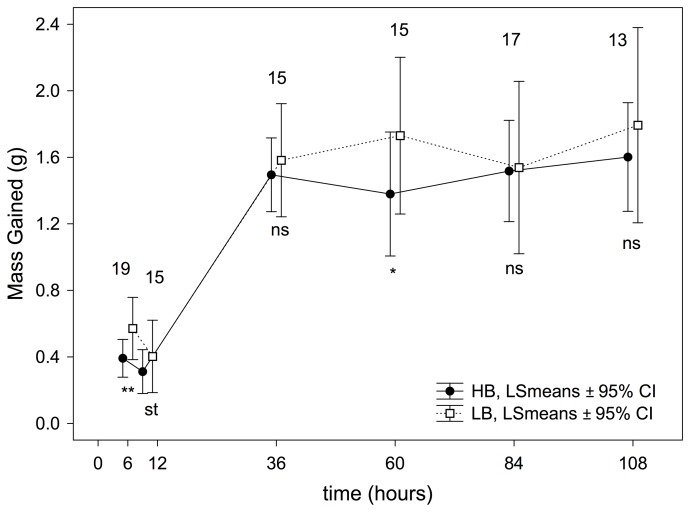
Effect of the experimental treatment on mass gained by nestlings and calculated from RM-ANOVAs in each experimental session.P-values are indicated as ns: P>0.05; st: 0.1≤P≥0.05; *: P<0.05; **: P<0.001 and ***: P<0.0001. Numbers of nests (i.e. those with measurements from the four nestlings) used in each one of comparisons are also shown.